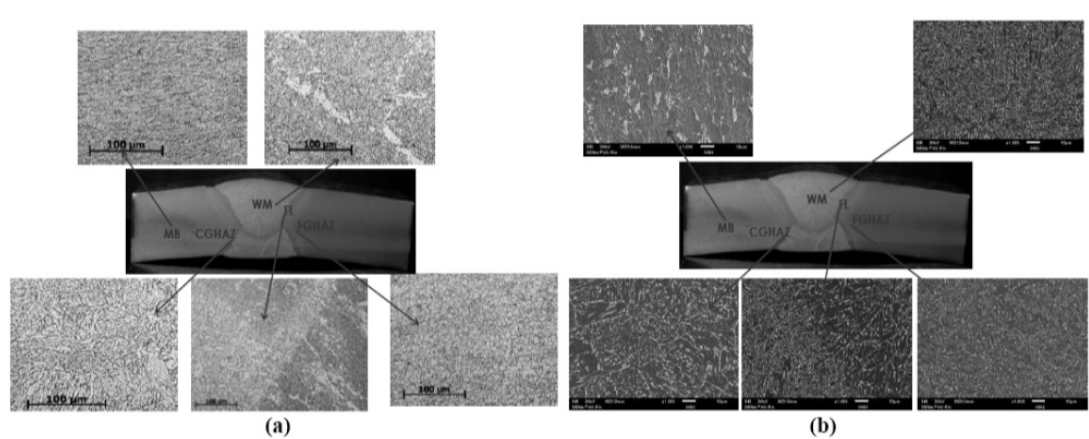
Figure 2. Microstructural Characterization of welded joint. (a) OM (b)